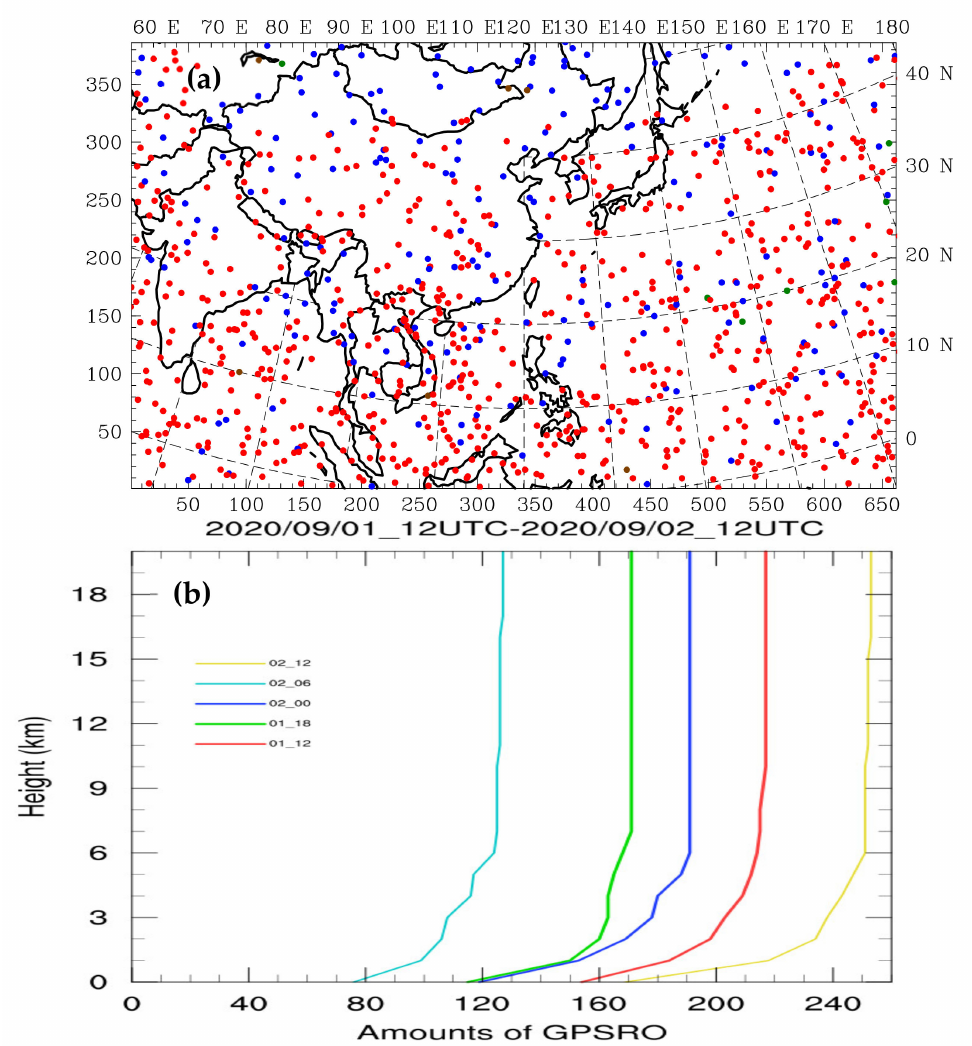
Figure 3. ( a ) The horizontal distribution of GNSS RO data during the 1-day DA period. There was a total of 959 RO soundings in the outermost domain, including 724 data from FORMOSAT- 7/COSMIC2 (red), 222 from MetOp (blue), 7 from KOMPSAT-5 (green), and 6 from PAZ (brown). ( b ) The vertical variation of the amounts of accumulated RO soundings at each DA cycling, e.g., 01_12 indicates the DA time at 1200 UTC 01 September 2020 (the first DA cycle), and 02_12 is for the DA time at the final DA